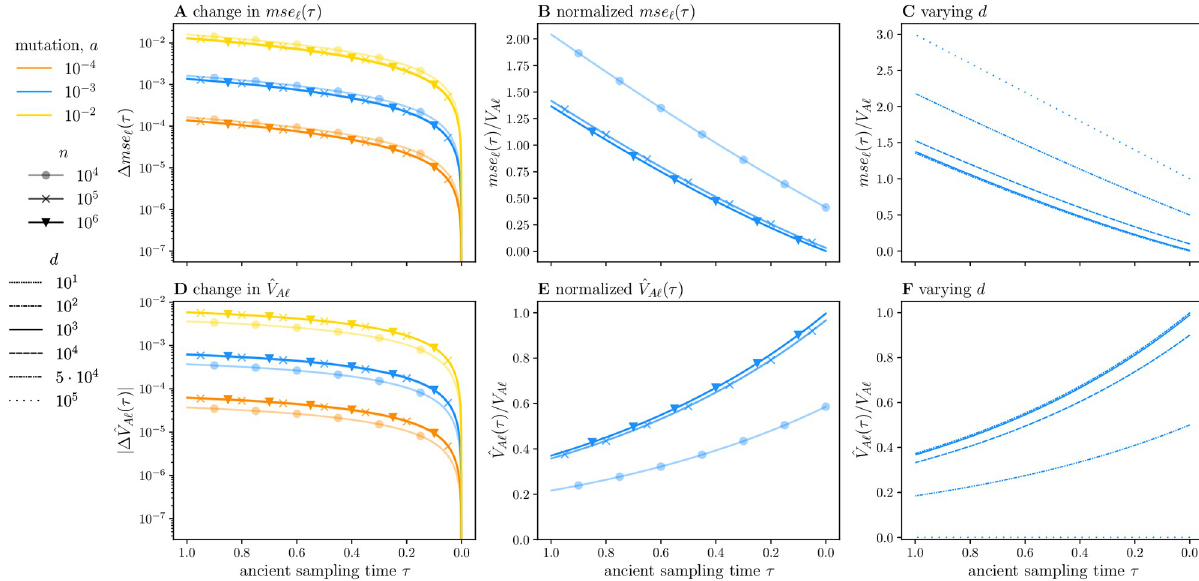
Fig 2. Per locus contributions to the mean-squared error and estimated additive genetic variance across sample sizes, mutation rates, and detection thresholds. In (A), we plot the per-locus increase in mse , Δ mse ( τ ), normalized by β 2 , for three mutation rates a = 10 − 4 , 10 − 3 , 10 − 2 by color, ℓ and for the three sample sizes, n = 10 4 , 10 5 , 10 6 by shape, respectively. For a squared effect size of β 2 = 0.01, each sample size, in part, specifies a value of d ℓ , with d = 4142, 3340, 3290, or sample allele frequencies of approximately 0.2, 0.02, and 0.002, in order of increasing sample size. In (B-C), we restrict ourselves to a = 10 − 3 as the lines for different mutation rates would otherwise largely coincide. In (B), we plot mse ( τ ) normalized by the expected ℓ additive genetic variance at stationarity, E ½ V � ¼ b 2 a = ð 2 a þ 1 Þ . In (C), we fix n = 10 4 and vary the detection threshold over several orders of A ‘ magnitude, d 2 {10, ... , 10 5 }, plotting mse ( τ ) normalized by E ½ V � . In (D-F), we repeat (A-C), but for the statistic ^ V ð t Þ , with the following exception: ℓ A ‘ A ‘ Because ^ V ð t Þ decreases with τ , we plot the absolute value of its difference from ^ V ð 0 Þ in (A). For all plots the ancient sampling time τ 2 [1, 0], which A ‘ A ‘ corresponds to a time span of 2 N generations.